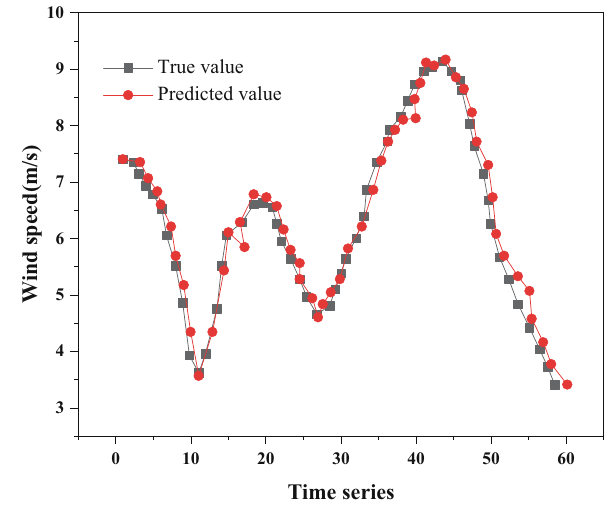
Figure 2: Combined model